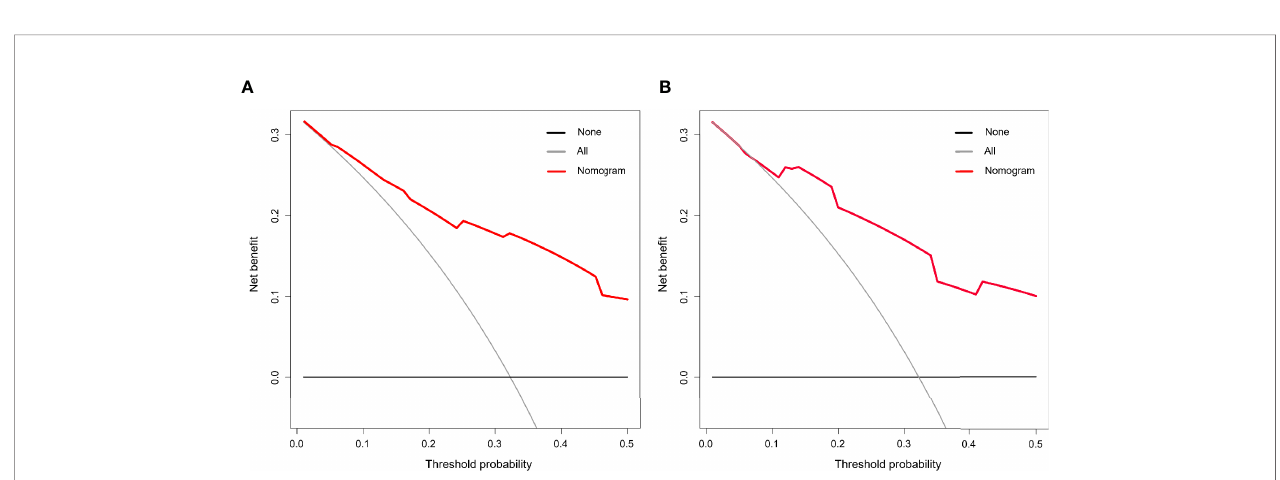
FIGURE 4 | Decision curve analysis (DCA) of the nomogram model. The threshold probability was calculated for the 3-year DFS. (A) DCA for the nomogram in the training cohort. (B) DCA for the nomogram in the validation cohort. The y-axis represents the net bene fi t. The x-axis represents the threshold probability. The grey and black lines represent the assumption that all and none of the patients had long-term disease-free survival.